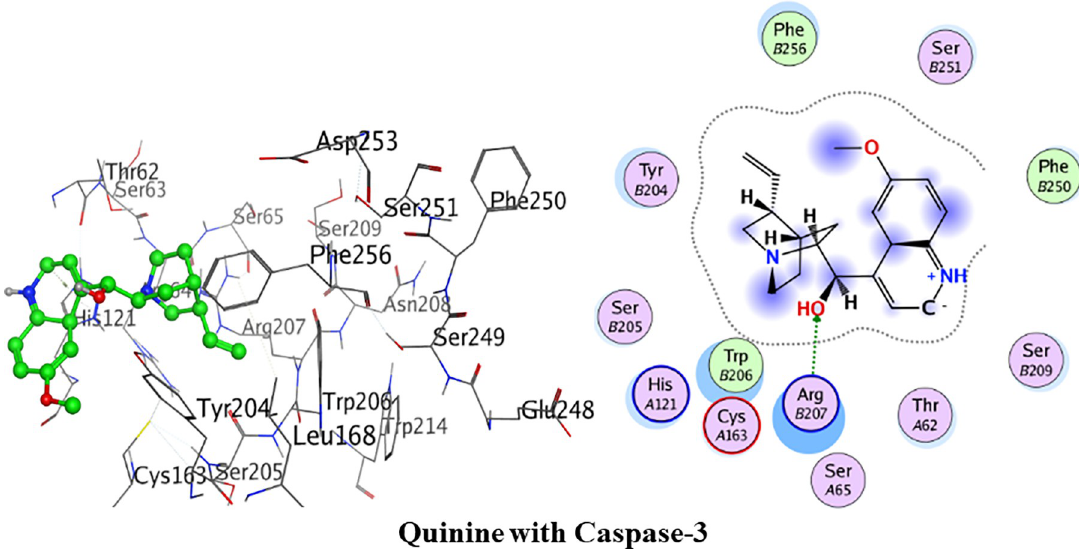
Fig 14. 3D and 2D interactions of quinine with active site of